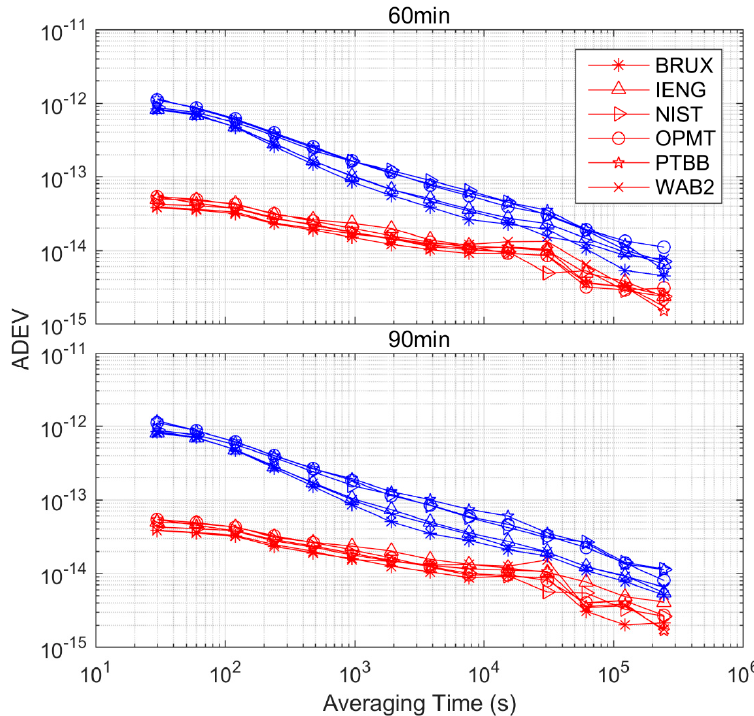
Figure 8. Allan deviation of scheme 1 ( blue ) and scheme 2 ( red ) at six stations for observation interruptions of 60 and 90 min.